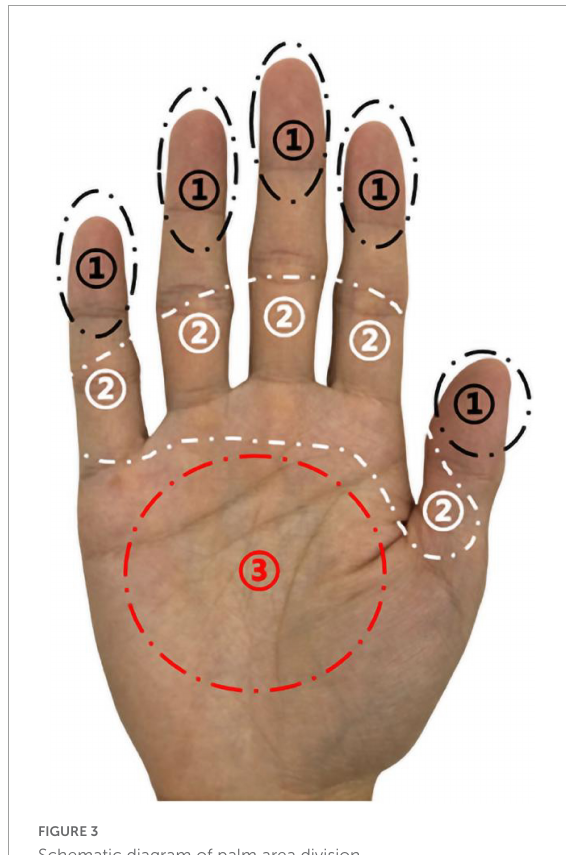
FIGURE3 Schematic diagram of palm area division.